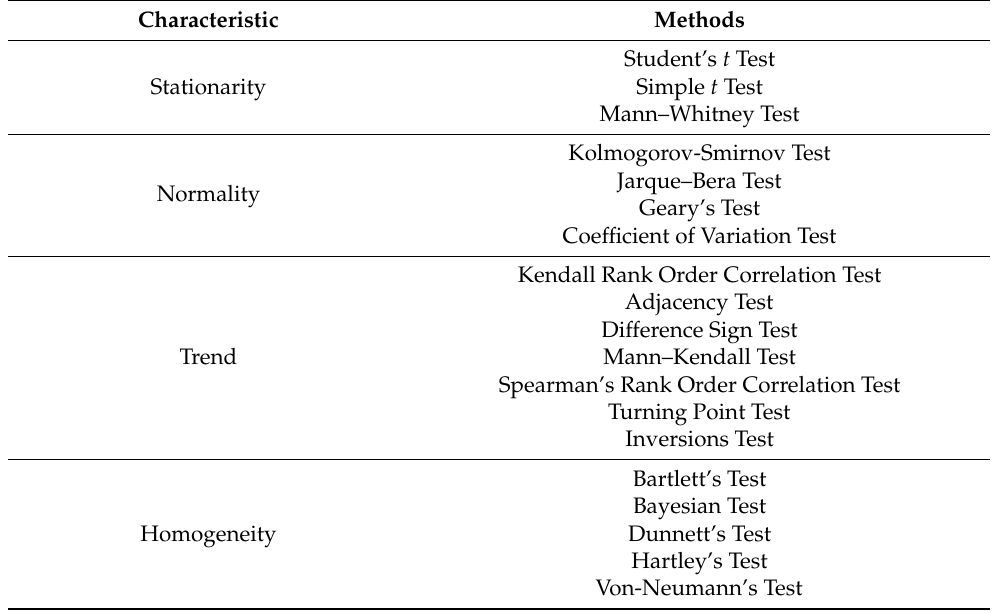
Table 1. Statistical